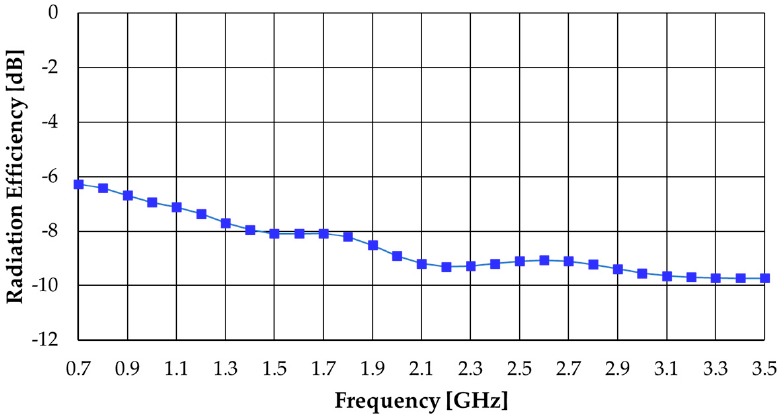
Figure 21. Simulated radiation efficiency results of the modified octagonal monopole with absorber and metal shield.